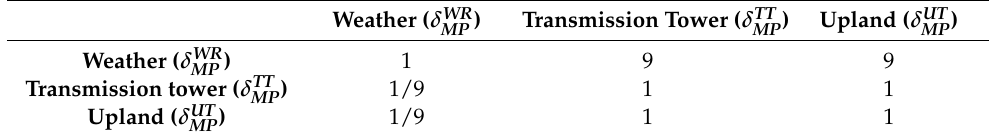
Table 12. Judgmental matrixes of threat source alternative hierarchy of mission point.